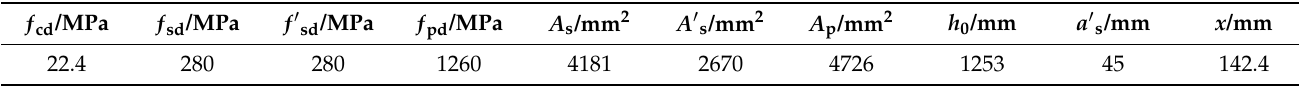
Figure 6. Equaled I-shape of the undamaged girder (Unit: cm). Table 2. Material and parameters of the undamaged box girder.